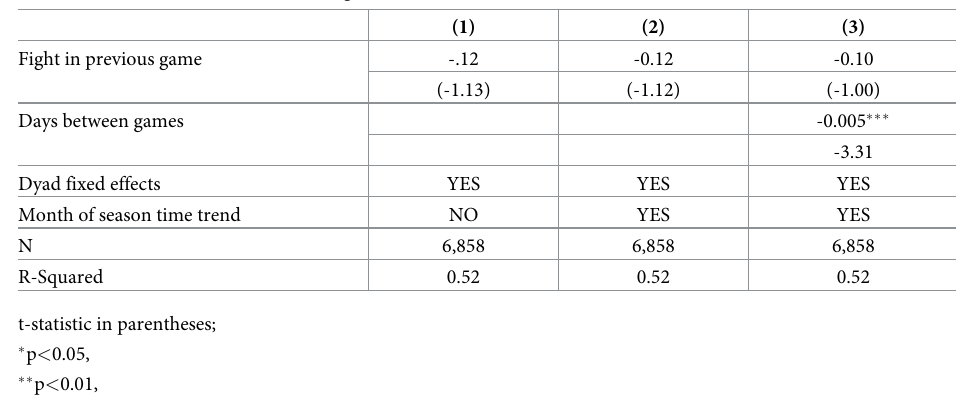
Table 5. Models of deterrence between